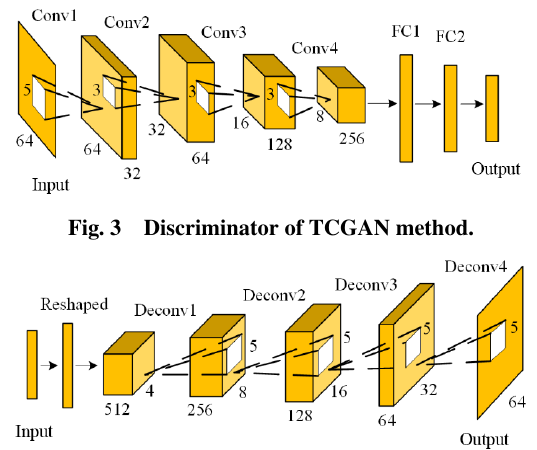
Fig. 4 Generator of TCGAN